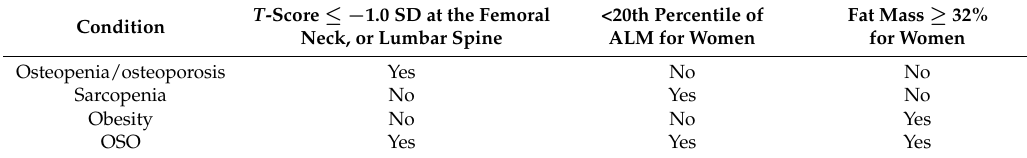
Table 2. Diagnostic criteria of OSO syndrome based on bone density and body composition.